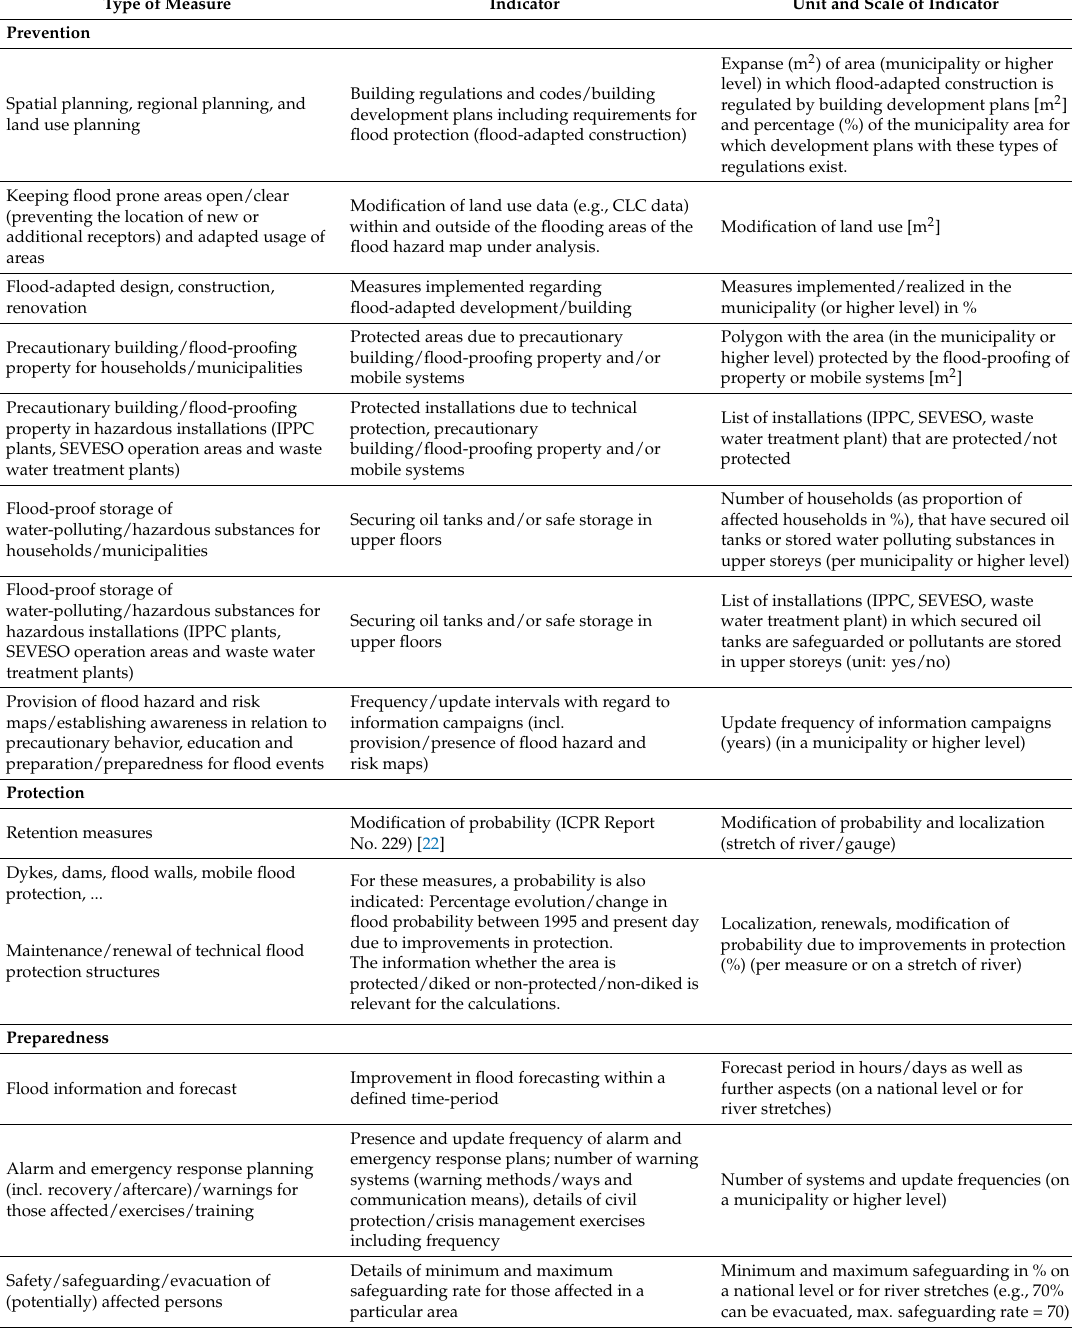
Table 1. Overview of the measures and indicators integrated into the tool and the calculations